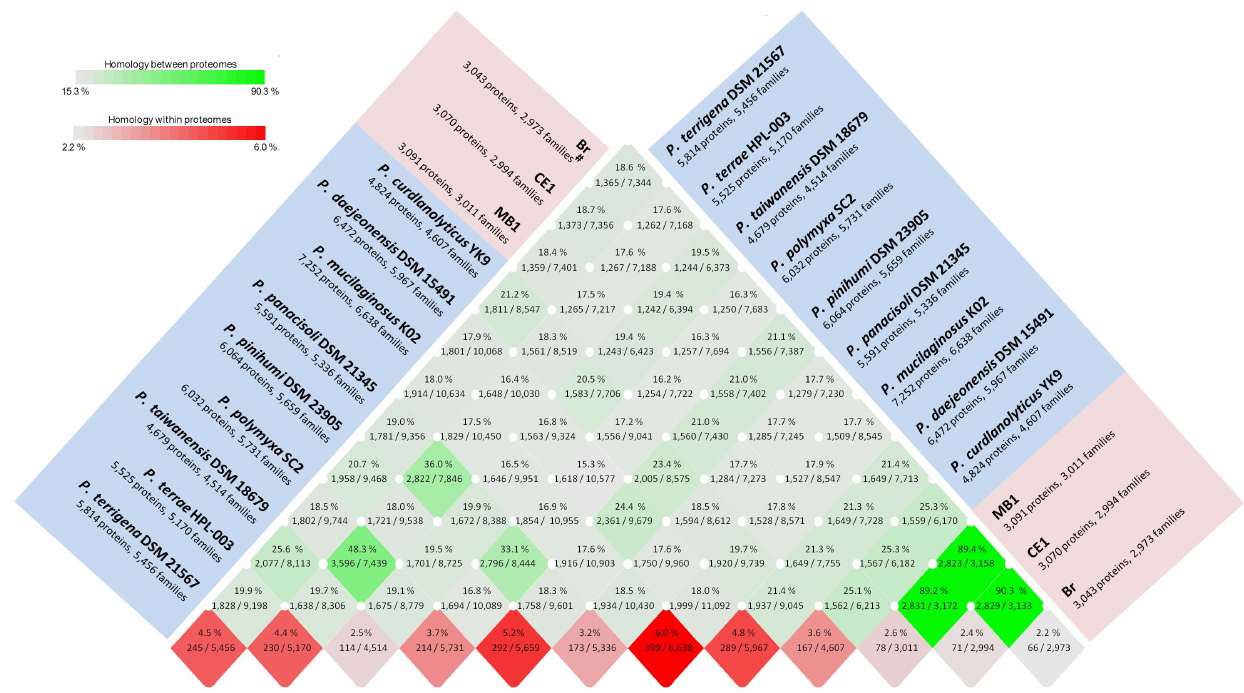
Figure 3. A BLAST matrix of an all against all protein comparison of 12 Paenibacillus genomes.